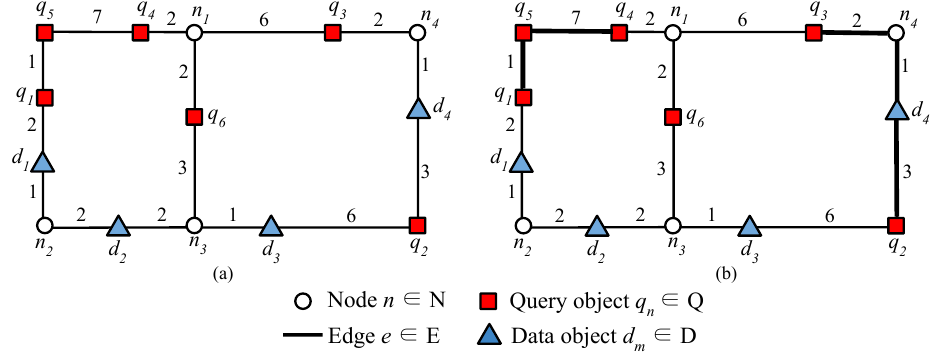
Figure 3. Initial Road network, and road network after clustering query objects, query object clusters are denoted by the bold lines ( a ) Nodes Clustering; ( b ) Query Objects